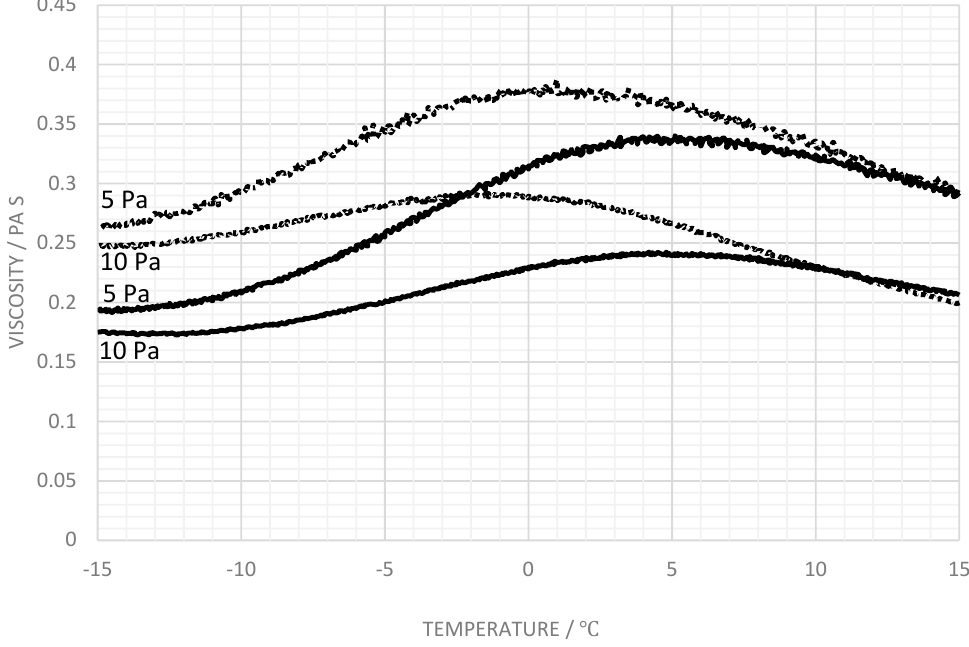
Figure 8. Viscosity variation for Carbomer A containing 0.030 wt% Na + and 0.045 wt% K + (A3K) ( ‒ ), and 0.075 wt% Na + (A3N) ( ∙∙∙ ) at shear stresses of 5 and 10 Pa.